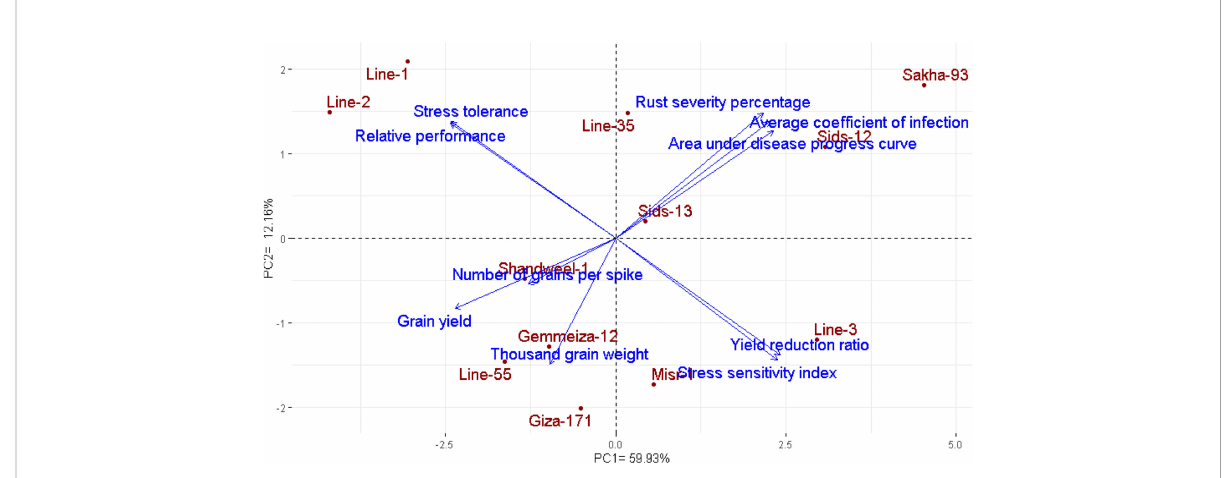
FIGURE 4 Biplot of PCA for the evaluated twelve bread wheat genotypes based on yellow rust resistance measurements, heat tolerance indices, and agronomic